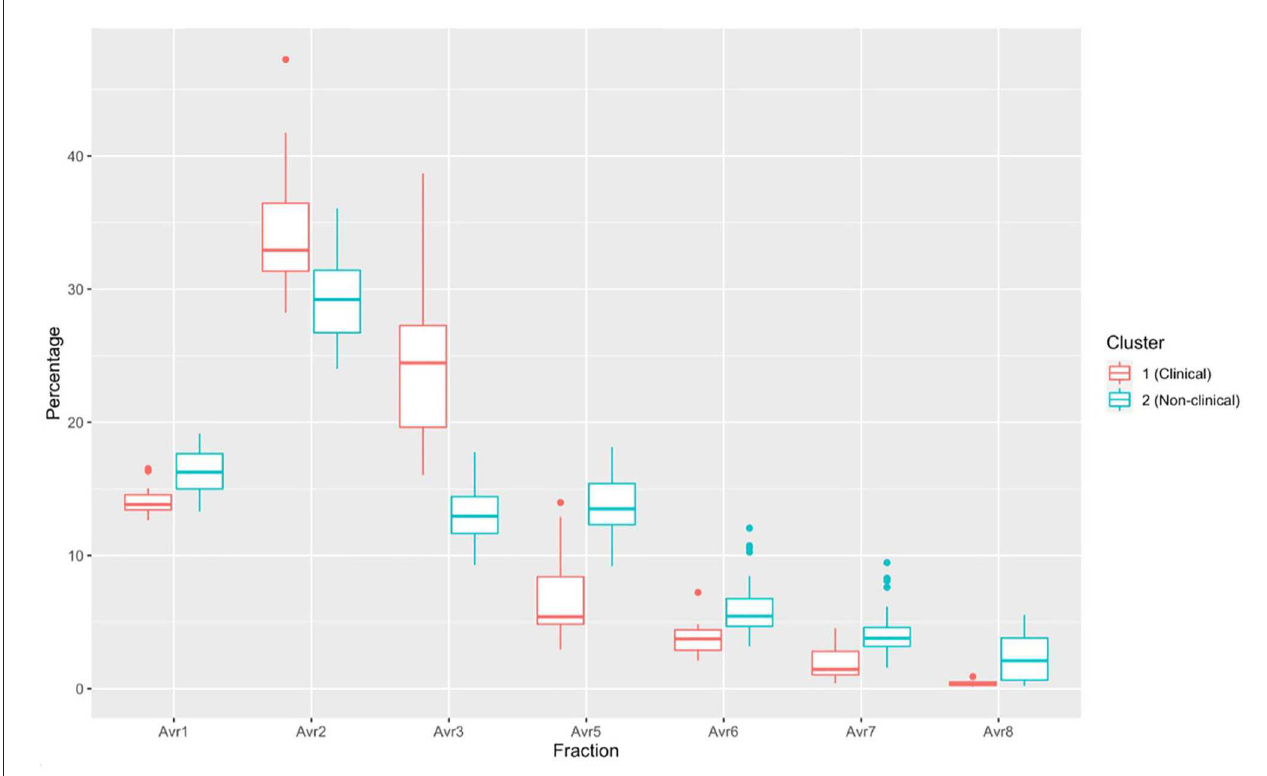
FIGURE11 Boxplots comparing each protein electrophoresis fraction for cluster 1 ( Batrachochytrium salamandrivorans ( Bsal ) infected, clinically diseased Taricha granulosa ) in red and cluster 2 (controls and Bsal -infected, non-clinically diseased T. granulosa ) in blue. Each box represents the interquartile range (IQR), the horizontal line within each box represents the median, vertical lines represent 1.5 * IQR, and dots represent outliers.